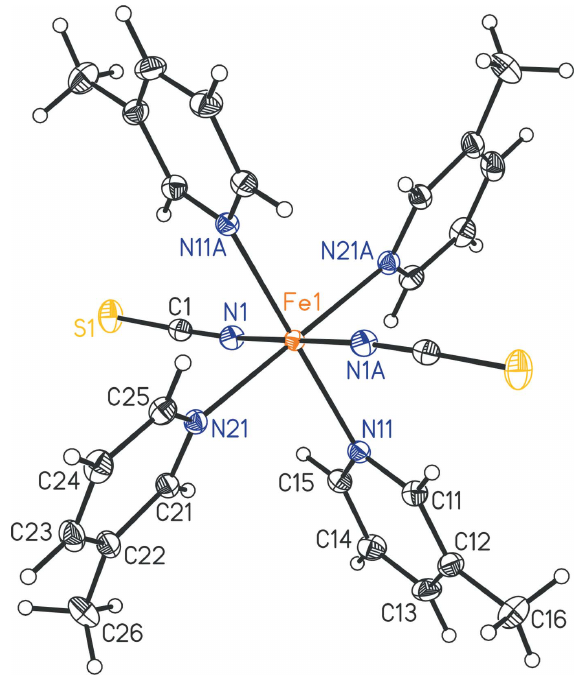
Figure 4 The molecular structure of compound 2 with displacement ellipsoids drawn at the 50% probability level. [Symmetry code: (A) 1 (cid:3) x , 1 (cid:3) y , 1 (cid:3) z .]